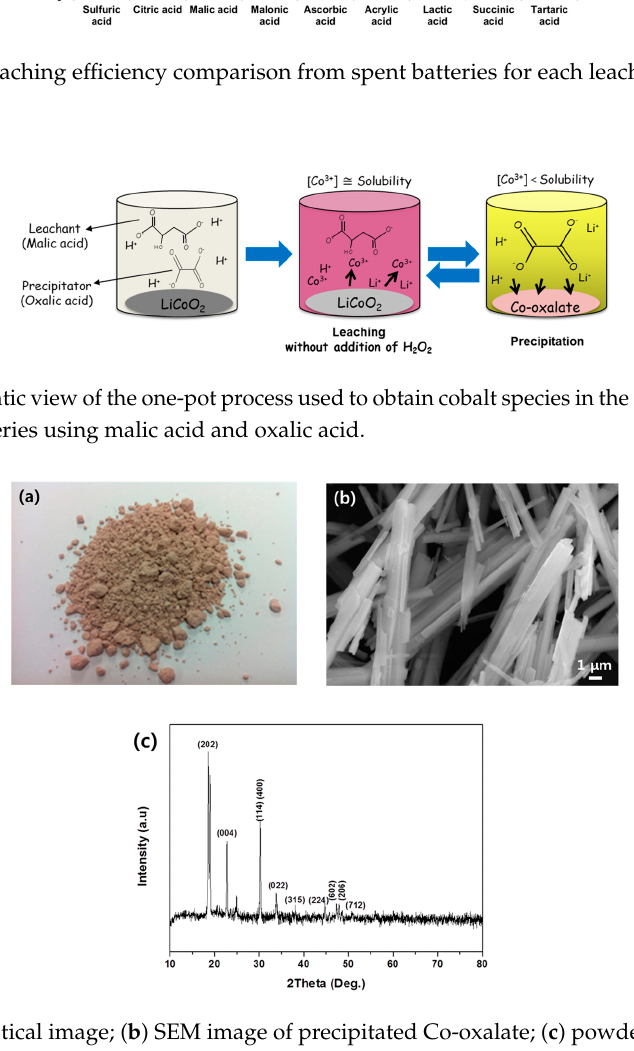
Figure 4. Fourier transform infrared (FT-IR) spectrum of the Co compound resulting from our process. Furthermore, oxalic acid allows for a process that does not employ H 2 O 2 as a reduction agent, without any loss of recovery efficiency (Figure 5). Previously, hydrometallurgical processes for recycling cobalt from spent lithium-ion battery have included the addition of H 2 O 2 . The presence of H 2 O 2 significantly favors the leaching of cobalt, since H 2 O 2 can reduce the Co 3+ to Co 2+ which is more readily dissolved than Co 3+ in malic acid (C 4 H 6 O 5 ) solution as described in Equation (1). In the absence of H 2 O 2 , the leaching efficiency of cobalt reached only 40%, as shown in Figure 5. In our one-pot process, however, the released Co 3+ from the spent cathode materials immediately react with oxalic acid (C 2 H 2 O 4 ) to form a cobalt oxalate precipitate; in other words, aqueous cobalt ions are removed from the solution (Equation 2). Hence, the removal of Co 3+ ions shifts the chemical equilibrium to facilitate the dissolution of Co 3+ ions by Le Chatelier’s principle, as shown in Figure 2. 2LiCoO 2 (s) + 3C 4 H 6 O 5 (aq.) + H 2 O 2 → 2Co 2+ (aq.) + 2Li + + 3C 4 H 4 O 52 − (aq.) + 4H 2 O + O 2 (g)